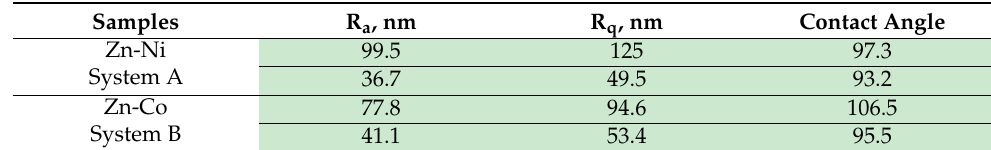
Table 1. Roughness values R a , R q and water droplet contact angle of the samples—Zn-Ni, Zn-Co and with addition of TiO 2 —System A and System B, respectively.